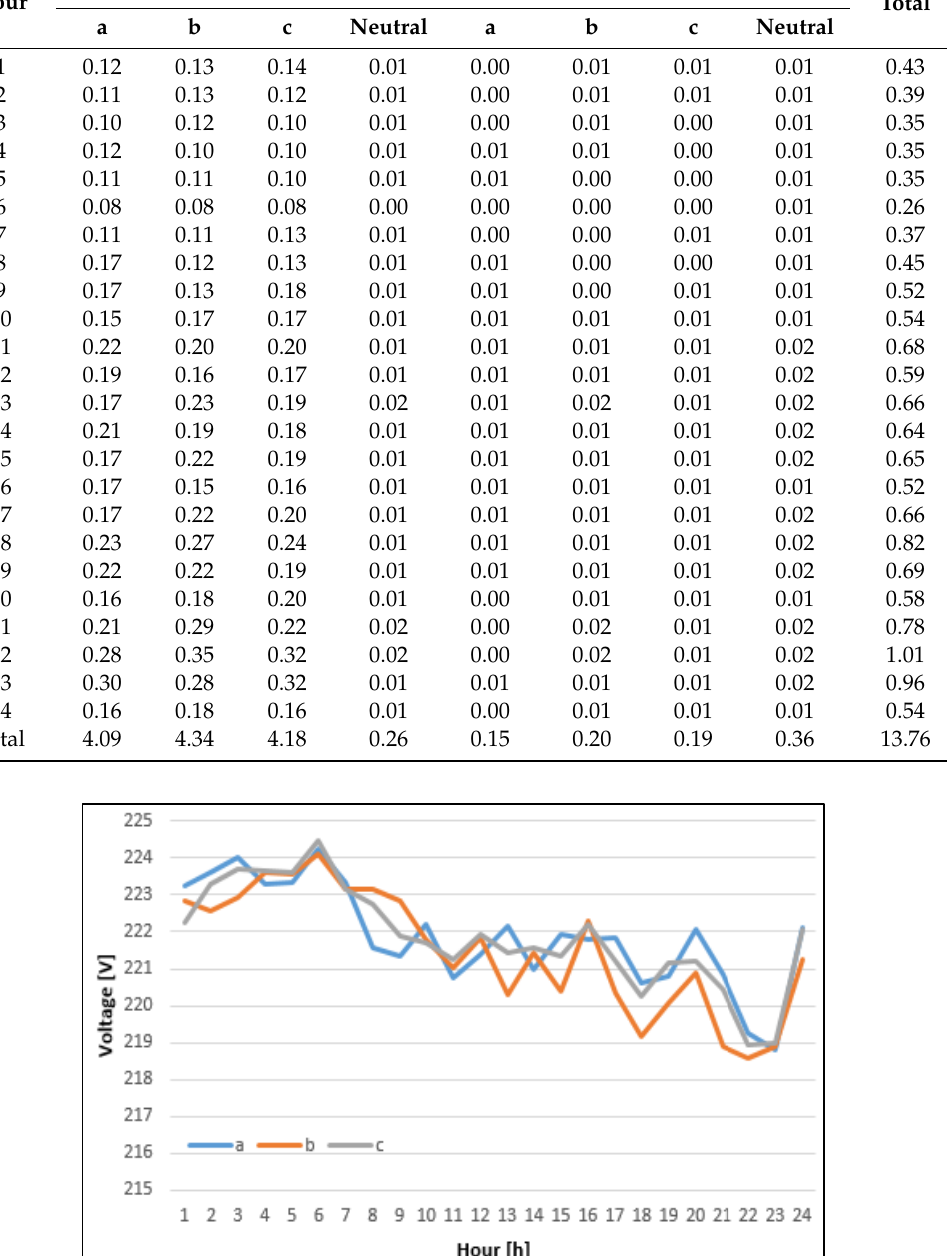
Table 9. The energy losses calculated with the data obtained using the proposed algorithm, [kWh]. Hour